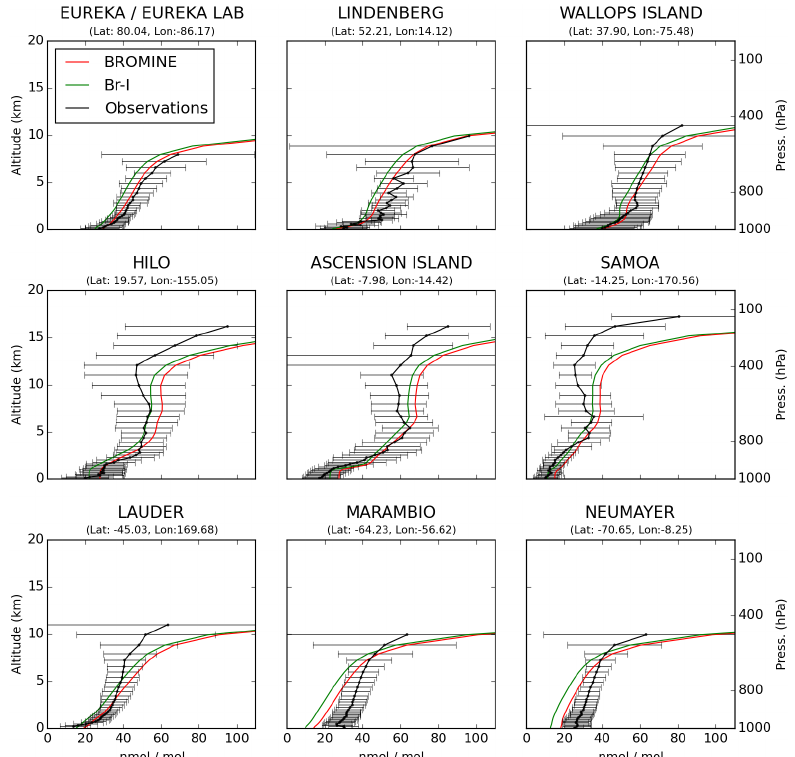
Figure 12. Comparison between annual modelled O 3 profiles and sonde data (2005, WOUDC, 2014). Profiles shown are the annual mean of available observations from World Ozone and Ultraviolet Radiation Data Centre WOUDC (2014) and model data for 2005 at given locations. Red indicates standard GEOS-Chem (v9-2) including bromine chemistry (“BROMINE”) and green with inclusion of iodine chemistry (“Br + I”). Observations (in black) show mean concentrations with upper and lower quartiles given by whiskers.